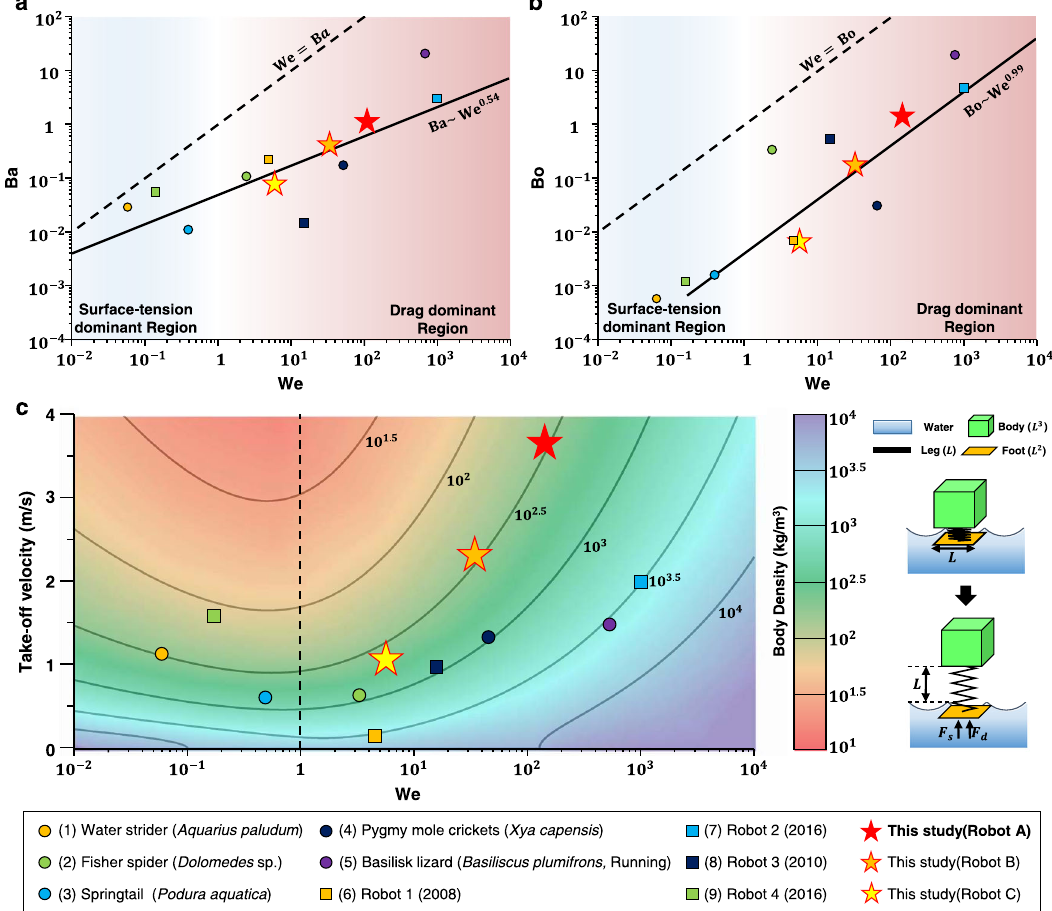
Fig. 1 | The trend of the Baudoin (Ba), Bond (Bo), and take-off velocity of jumping animals and robots depending on Weber (We) number. a , b Baudoin (Ba),Weber (We),and Bond (Bo) number for insects and robotsjumping onwater. Bold lines indicate the dependence of the best- fi t line (Ba=0.0496We 0.54 , r 2 =0.597, Bo=0.0038We 0.99 , r 2 =0.7221) and dashed line indicate the Ba=We and Bo=We, respectively. The blue region indicates that the jumping locomotion of systems is dominated by surface tension rather than drag (We«1), and the systems locomotion in the red region is dominated by drag rather than surface tension. c The take-off velocity of the insects and robots depends on the Weber number.